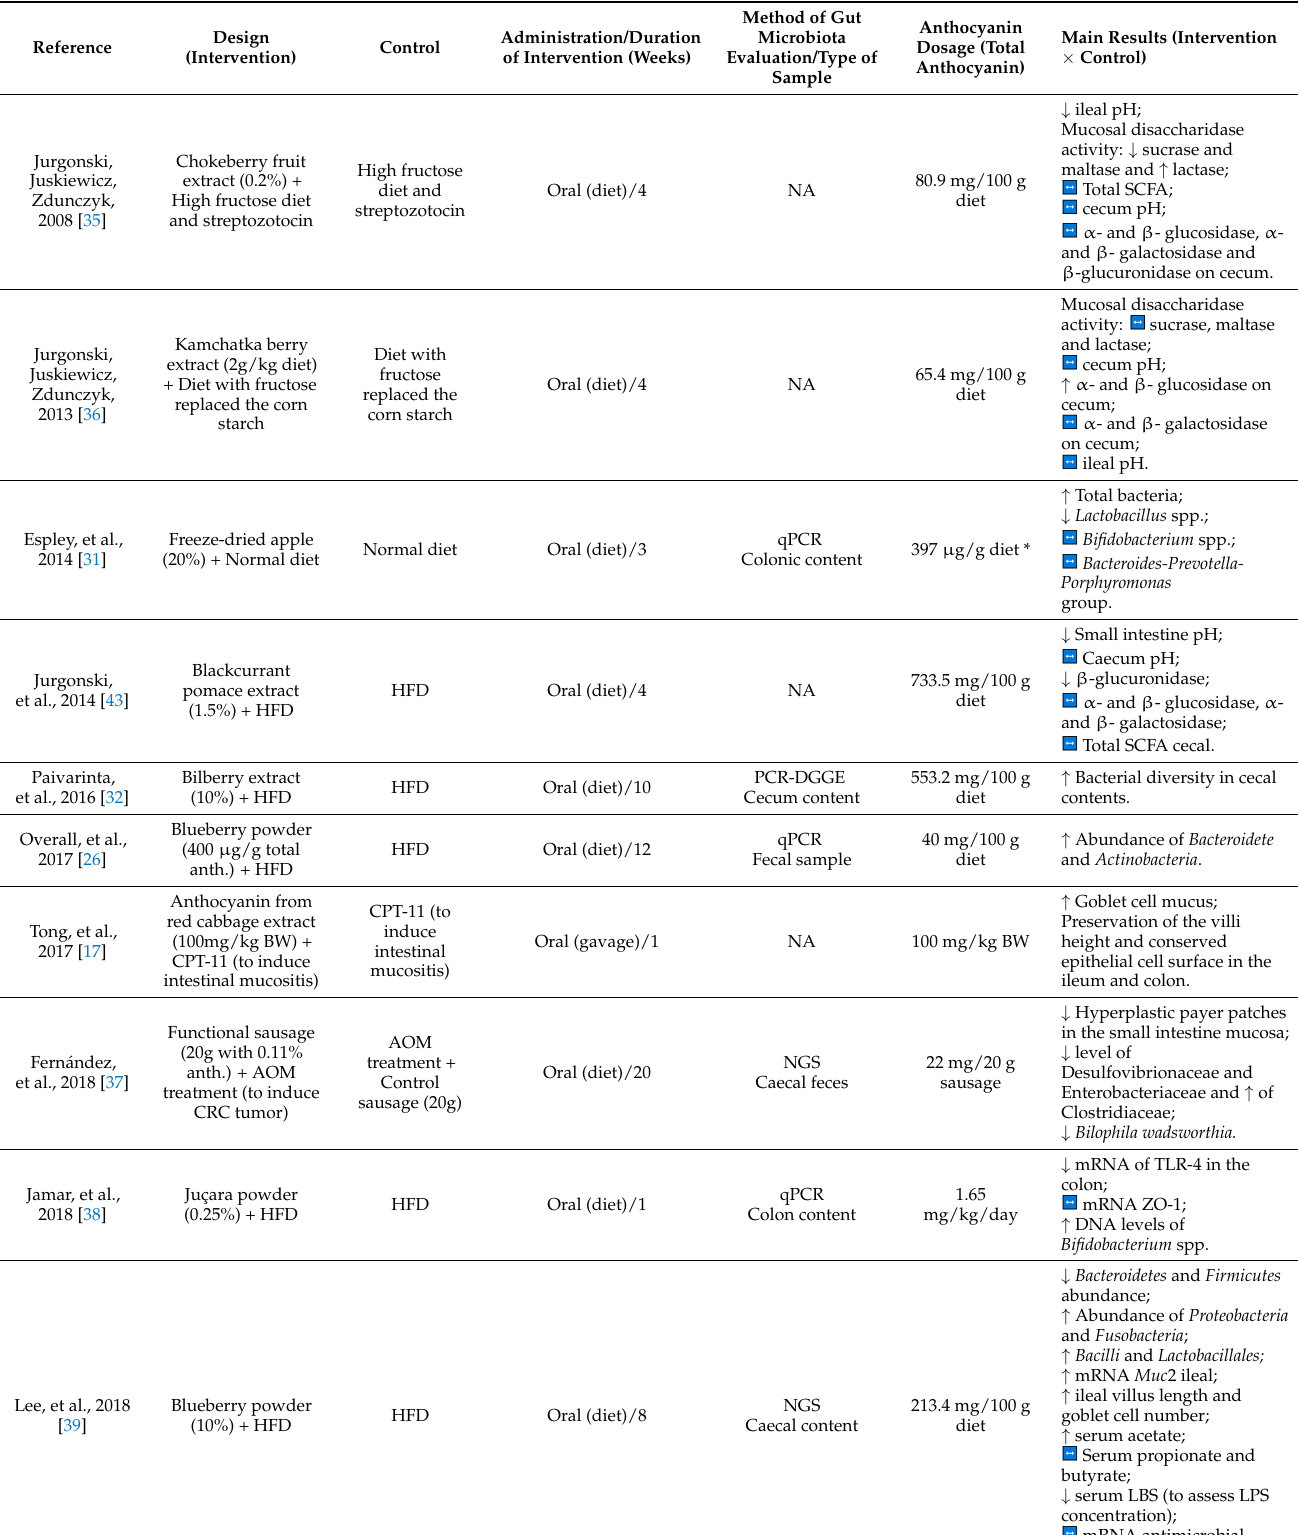
Table 3. Main findings in animal studies on the effects of anthocyanin on intestinal